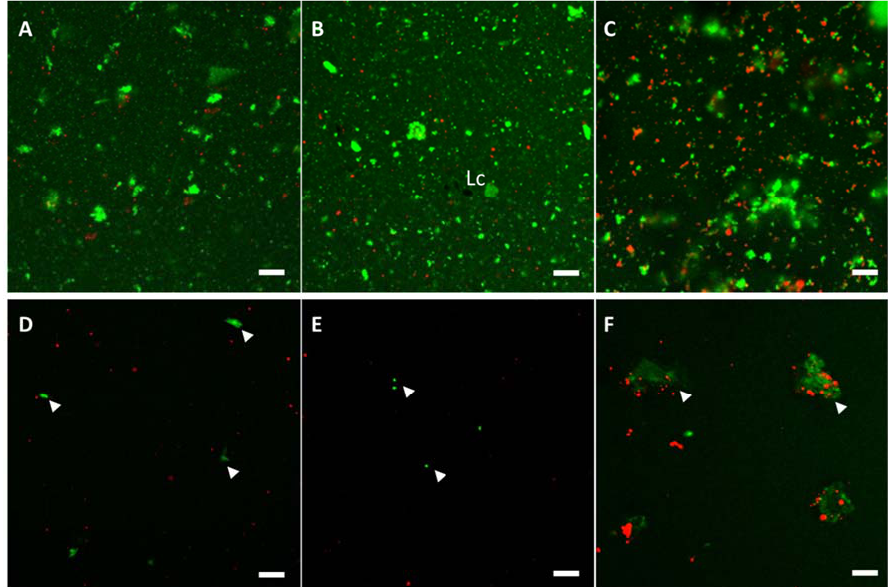
Figure 2. CLSM of whey powder (WP) ( A ), whey protein concentrate (WPC) ( B ) and Y08 ( C ) samples rehydrated with water (upper row) and subsequently solubilized with urea/DDT buffer (lower row). The effect of the buffer is evident comparing ( A – C ) panels with the corresponding ( D – F panels. Arrowheads indicate insoluble aggregates. Protein is green and fat is red. Lc: lactose crystal. Bars are 10 µm.